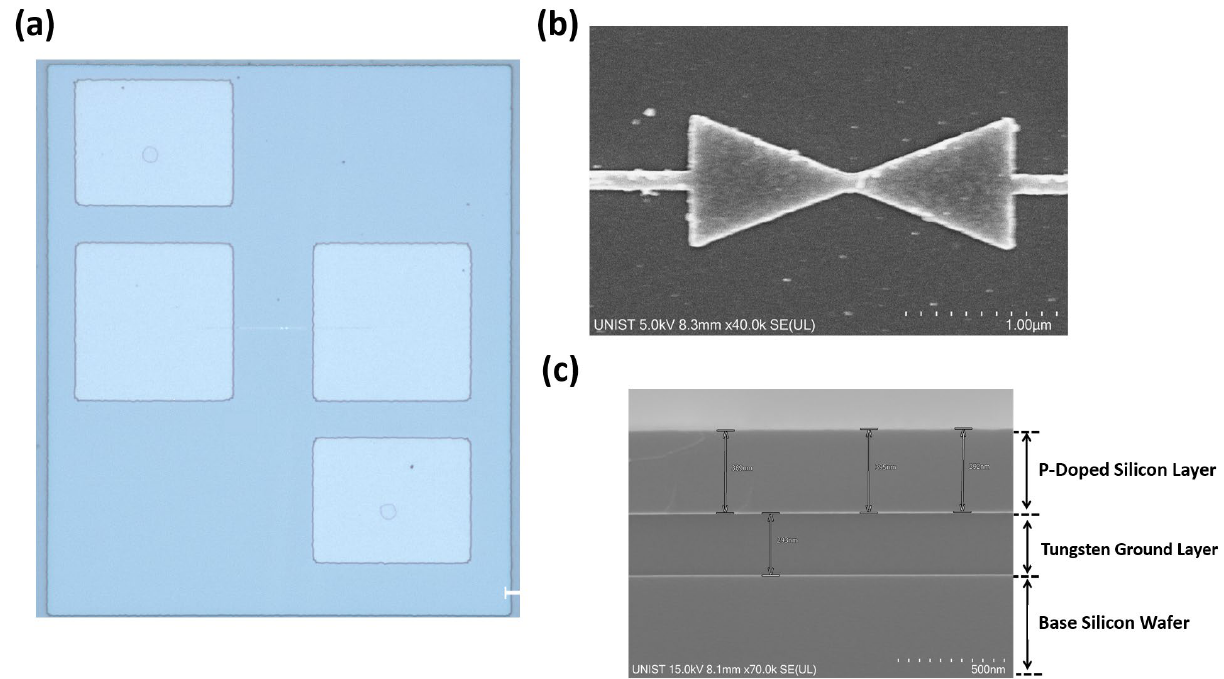
Figure 4. ( a ) The top view of fabricated device from an optical microscope with four measurement pads for DC and IR measurements. ( b ) The top view scanning electron microscopy ( SEM) image of nanoantenna. ( c ) SEM image of cross-section of fabricated device.